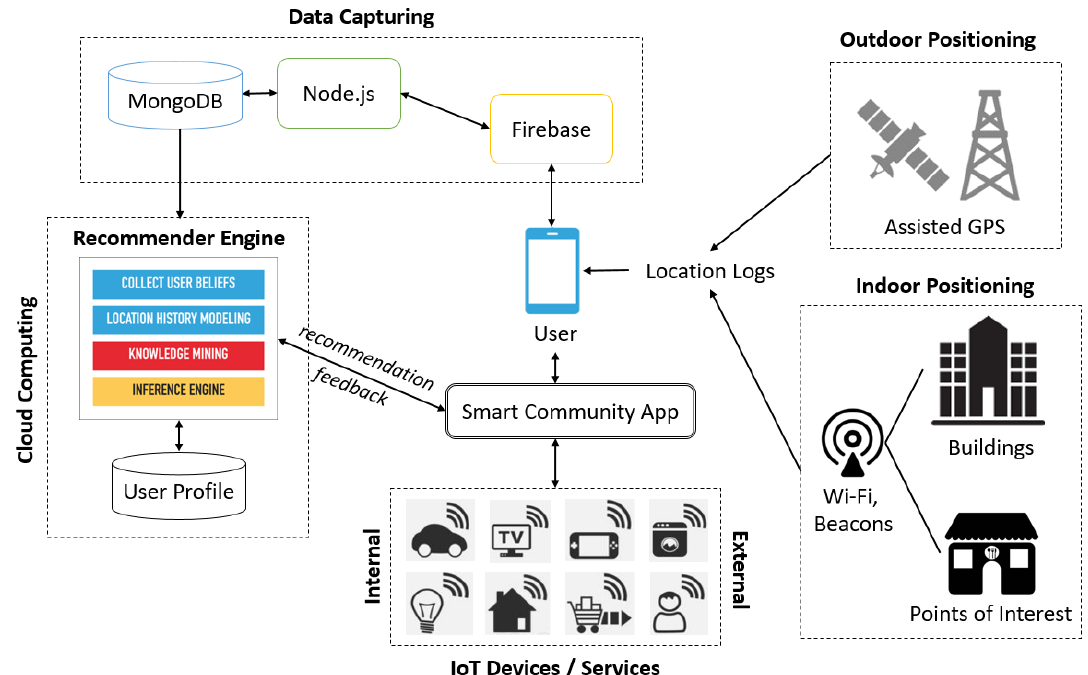
Figure 4. Overall SIoT architecture.